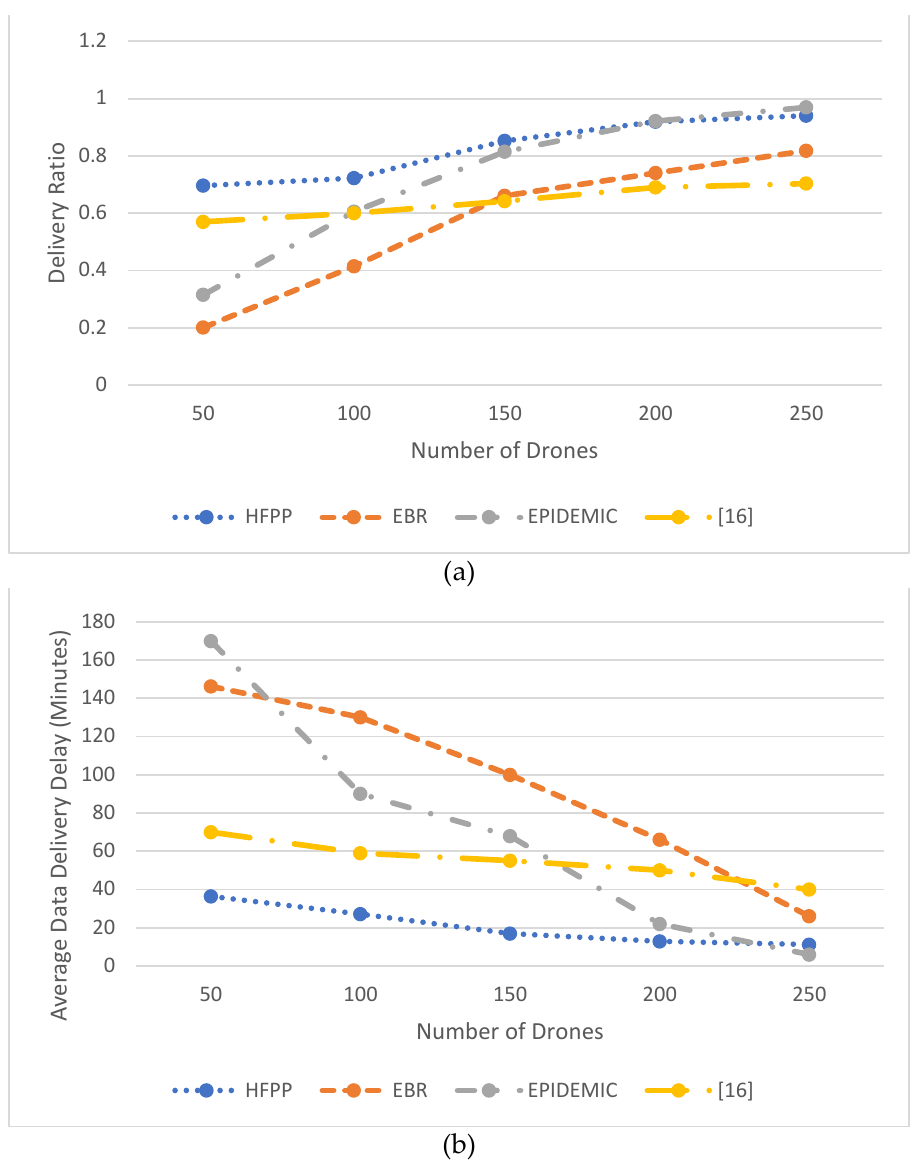
Figure 3. ( a ) delivery ratio of comparable schemes, ( b ) average data delivery delay of comparable schemes, when number of drones varies.